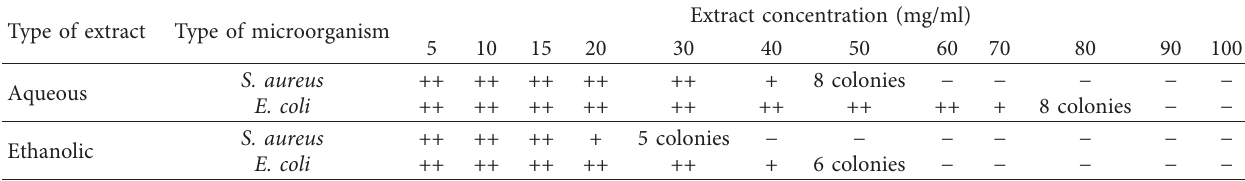
Table 2: Antimicrobial effects of pomegranate peel extracts on S. aureus and E. coli . Type of extract